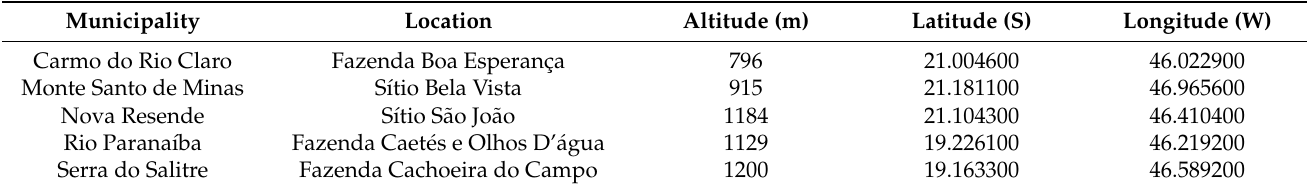
Table 1. Location of areas for validation of forecast systems in five municipalities in the state of Minas Gerais, Brazil. Municipality